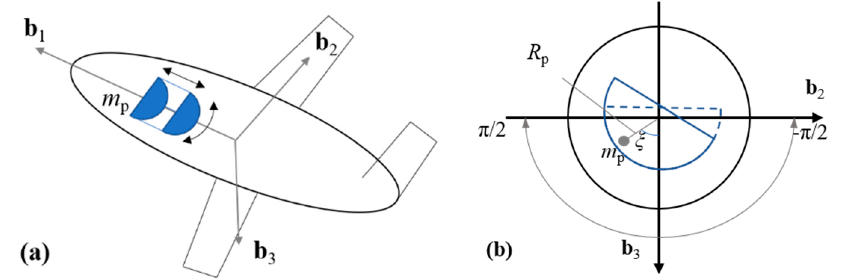
Figure 3. Principle of attitude regulation of underwater glider. ( a ) Overview of pitch and roll regulation; ( b ) Details of roll regulation.